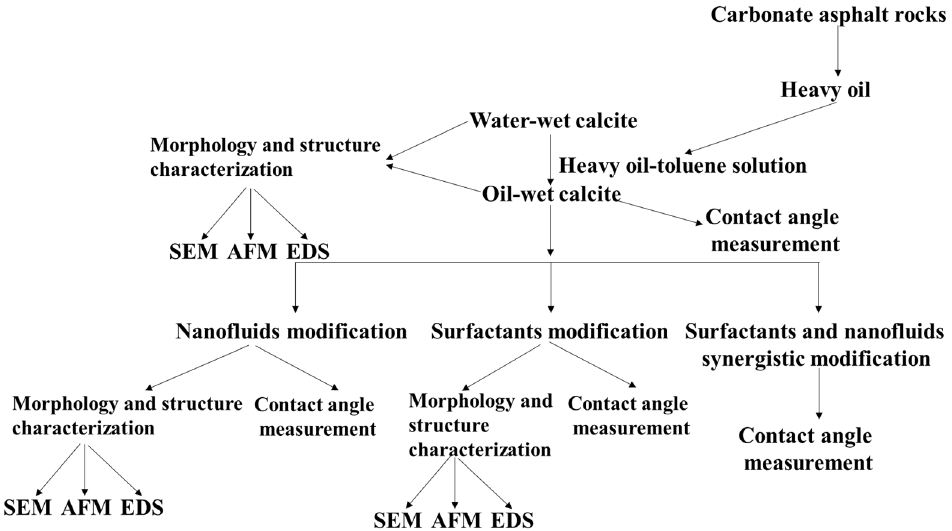
Figure 1. Scheme of the experiment procedure.